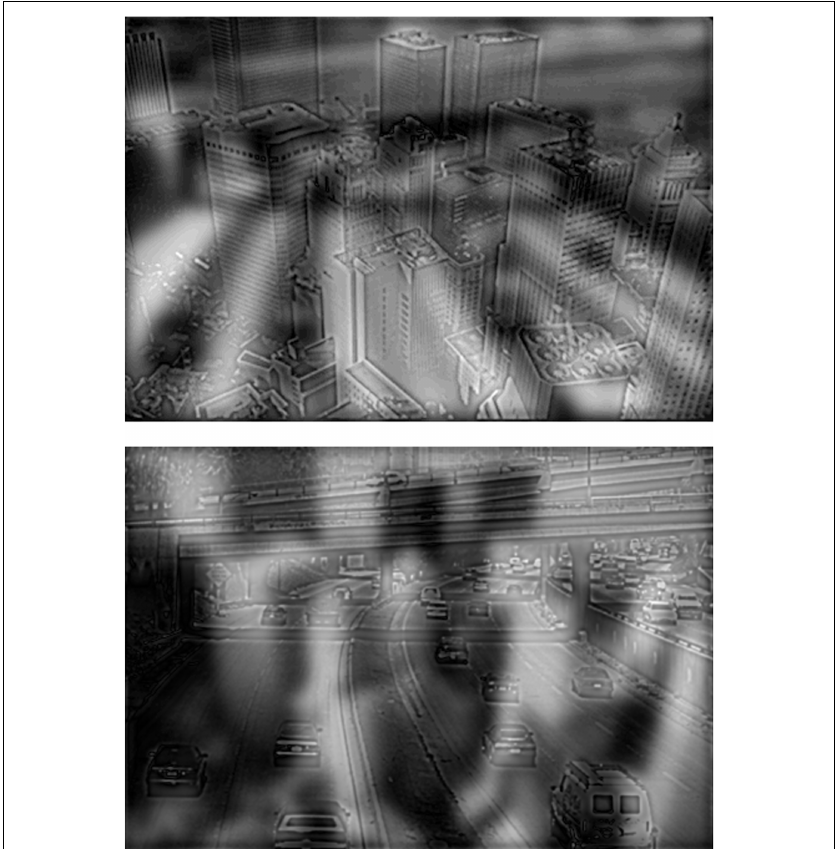
FIGURE 1 | Illustration of complex visual information and dimensionality reduction (adapted from Schyns and Oliva, 1994). The top picture illustrates the overlapped buildings making up a city. The bottom picture illustrates the road, bridges and cars characterizing a highway. Squint or step away from the picture to perform a different dimensionality reduction of the input and thereby reverse your